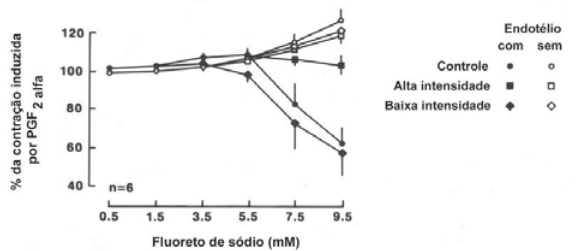
Fig. 5 - Relaxamento dependente do endotélio induzido por fluoreto de sódio (NaF) em artérias coronárias caninas. As artérias foram expostas à baixa ou alta intensidade de energia ultra-sônica e (PGF ). Quando a contração contraídas com prostaglandina F 2 α 2 α induzida pela PGF estabilizou, as artérias foram submetidas a 2 α concentrações crescentes de NaF. Os dados estão apresentados como médias ± erro padrão médio e observaram-se diferenças estatisticamente significantes (n = 6, p<0,05)